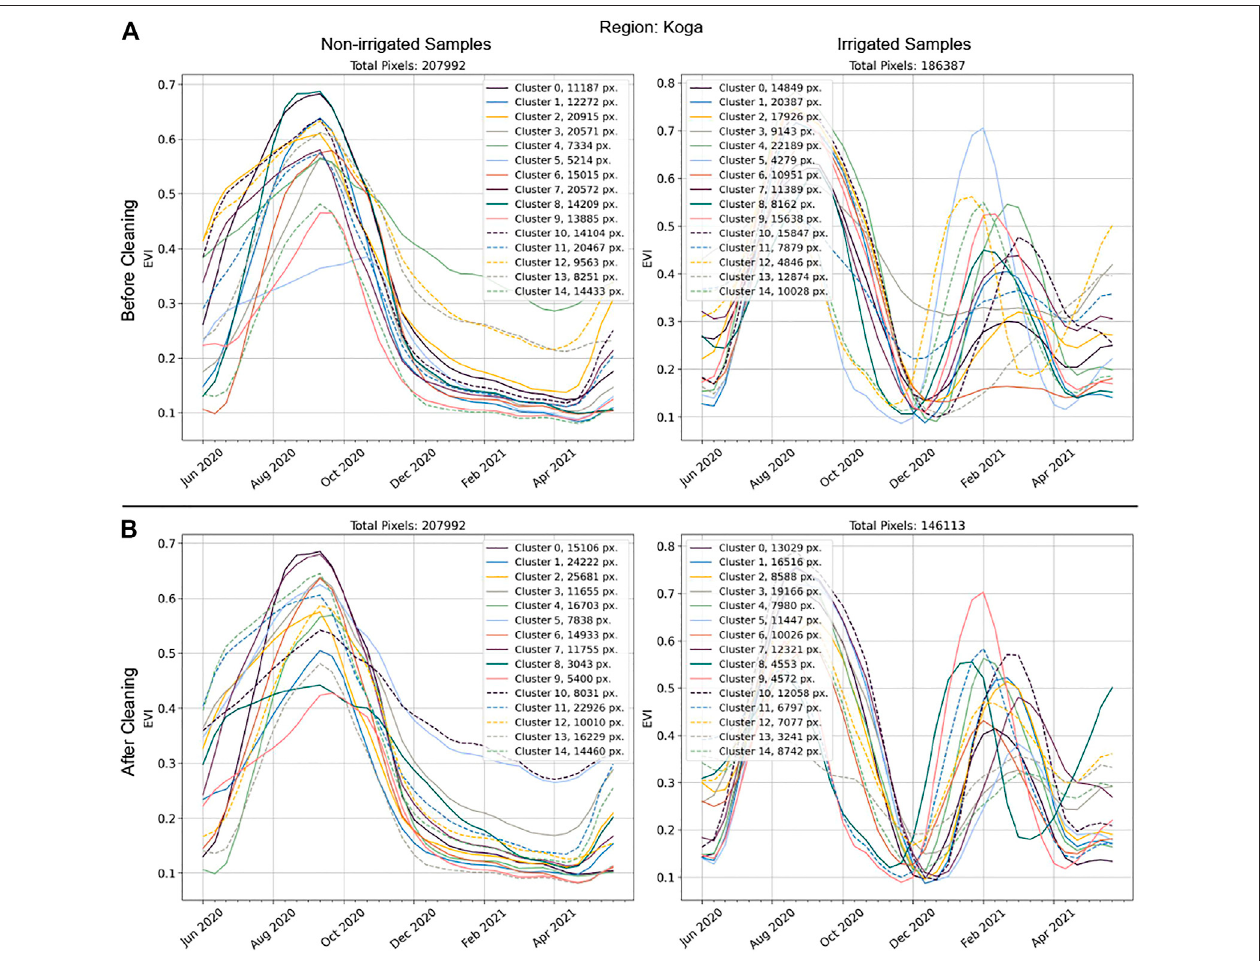
FIGURE 3 | Clustered enhanced vegetation index (EVI) timeseries before and after cluster cleaning for the Koga visual collection (VC) region. Before and after cleaning, pixels are grouped into one of 15 randomly indexed clusters. In (A) , Clusters 3, 6, and 13 of the irrigated samples are discarded due to either (6, 13) not containing a clear EVI peak above 0.2 during the dry season (December 1 st to April 1 st ); or (3) not containing successive EVI values below 0.2. All non-irrigated clusters display asingle vegetation peak aligned with the main rainy season, and the irrigated clusters after cleaning (B) all display a vegetation cycle during the dry